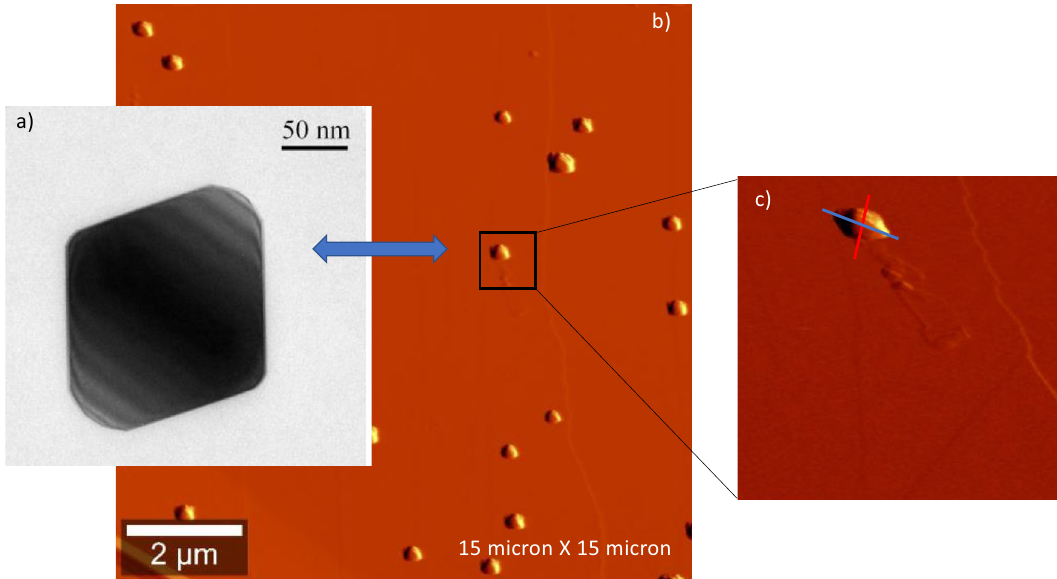
Figure 1. ( a ) Transmission electron microscopy image of a crystalline Si-NP; ( b ) Atomic force microscopy image of single Si-NP deposited on a HOPG substrate; ( c ) the enlarged area represents the area under the Raman laser